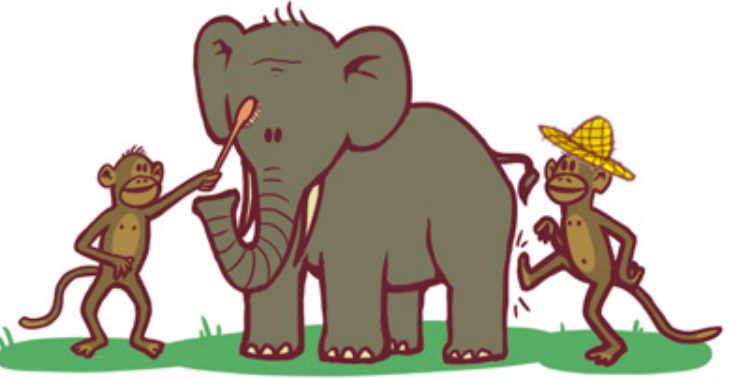
Figure 1. Modifying the agent of an action.